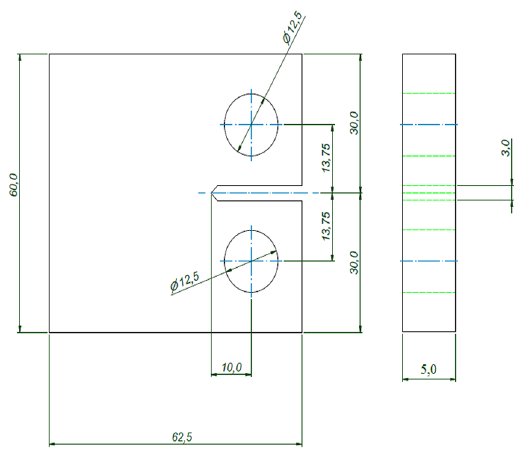
Figure 1. Size and geometry of the C(T) specimens (dimensions in millimeter). ASTM E647-11 14